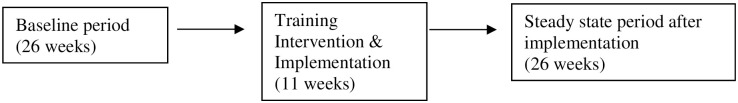
Schematic timeframe of the study.